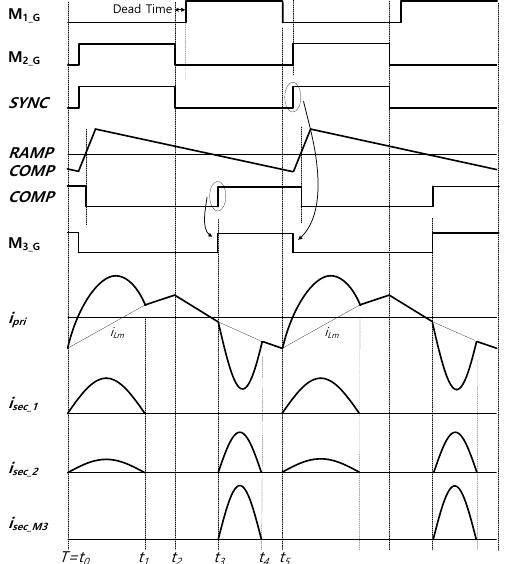
Figure 4. Key waveforms of proposed converter.